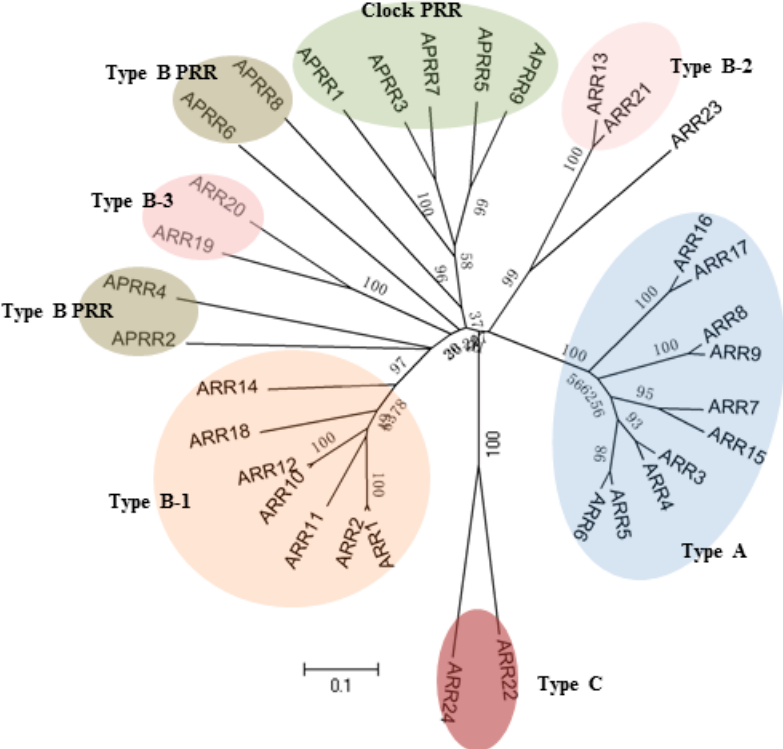
Figure 5. Phylogenetic relationship of response regulators (RRs) in Arabidopsis .